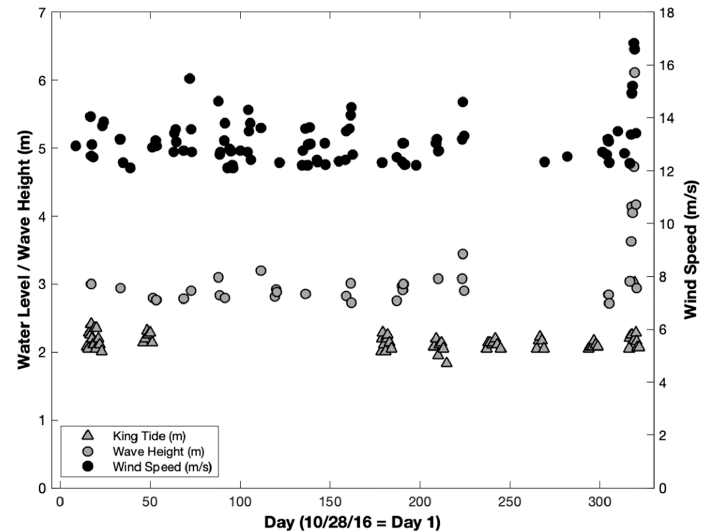
Figure 4. Forcing events (king tide and wave and wind events) observed at the Isle of Palms study site. All king tide events are shown. Only wave and wind events exceeding two standard deviations are displayed.